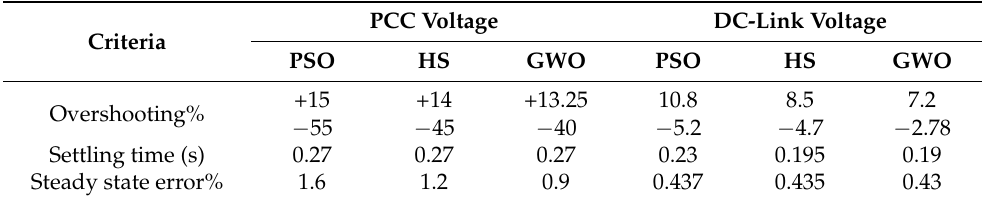
Figure 11. DC-link voltage during the three-phase fault case study. Table 2. Control sensitivity analysis. Figure 10. PCC voltage profile during the three-phase fault case study.